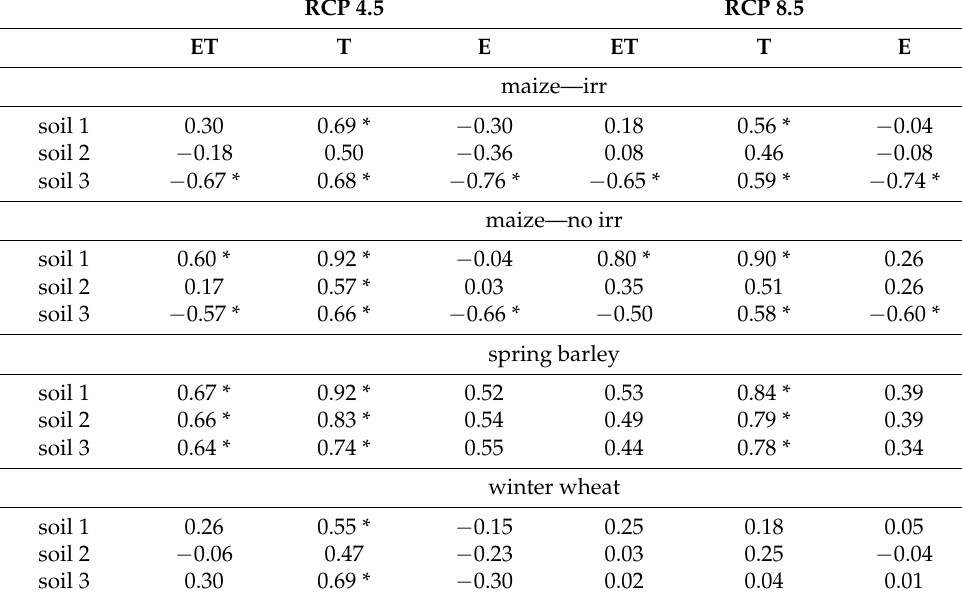
Table 5. Pearson’s correlation coefficients of evapotranspiration (ET), transpiration (T), evaporation (E) compared with relative yield differences (projections vs. ZAMG simulations) for grain maize (optimal irrigated = irr; rainfed = no irr), spring barley (no irr), and winter wheat (no irr) in the three different soil classes for RCP 4.5 (a) and RCP 8.5 (b); 1981–2010 in